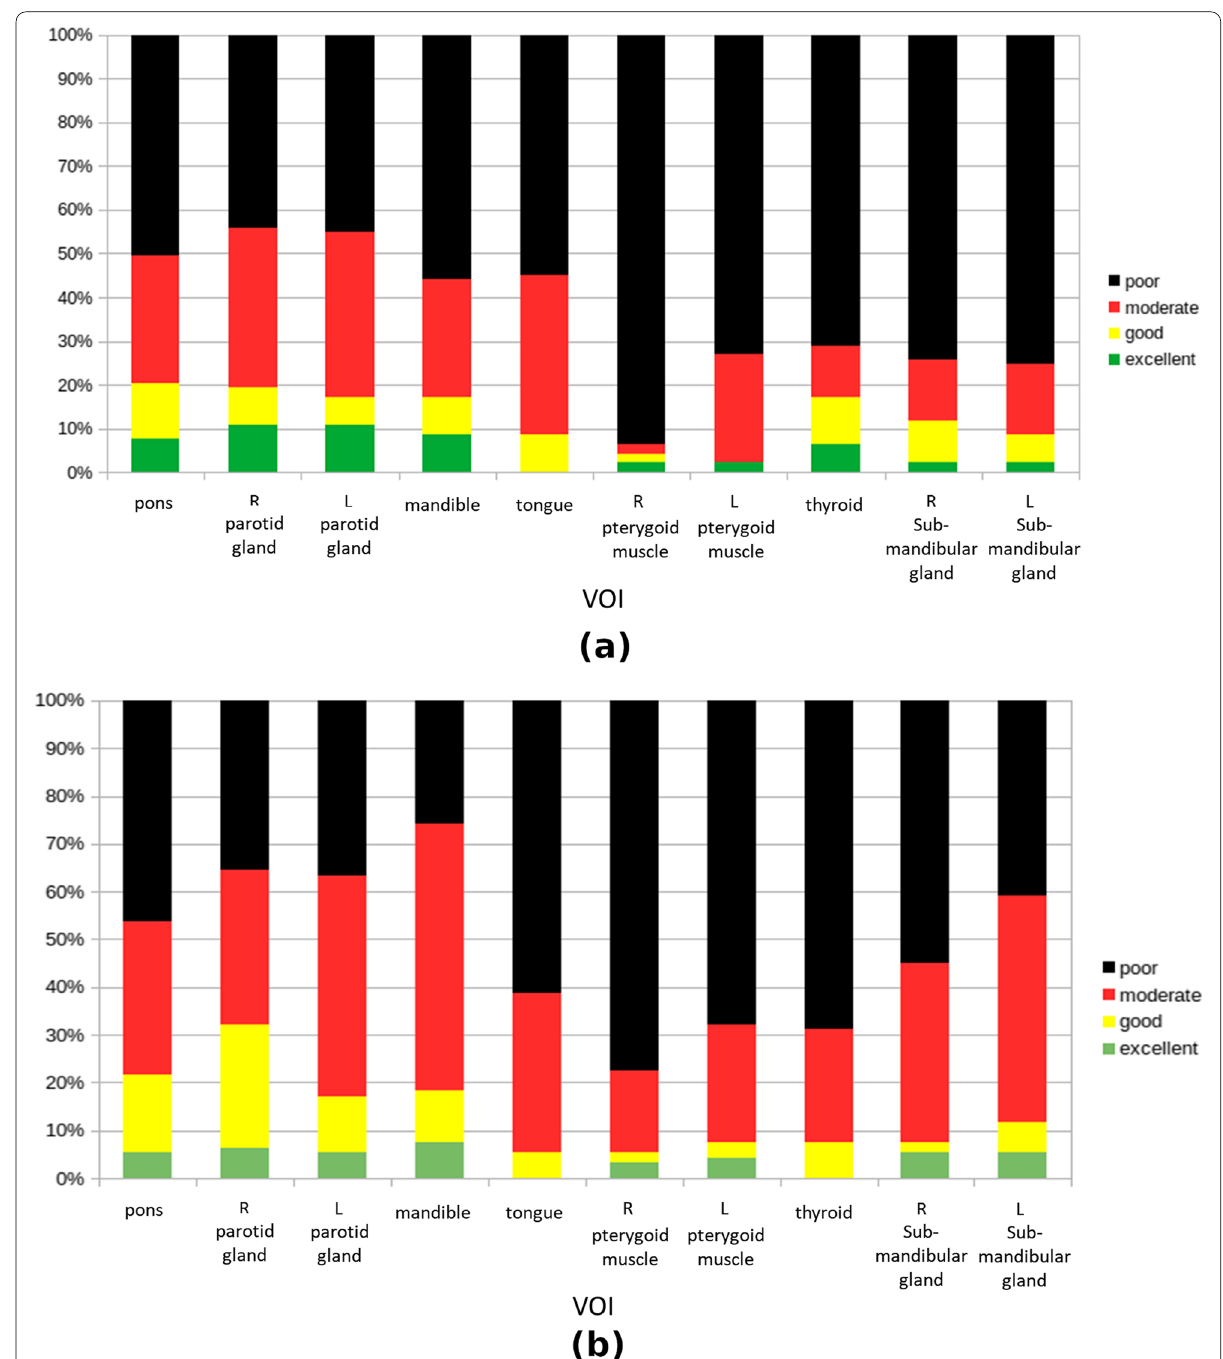
Fig. 4 Percentages of excellent, good, moderate, and poor ICCs of radiomics features in different tissue VOIs for ( a ) 3D-T1W-TSE and ( b ) 3D-T2W-TSE pulse